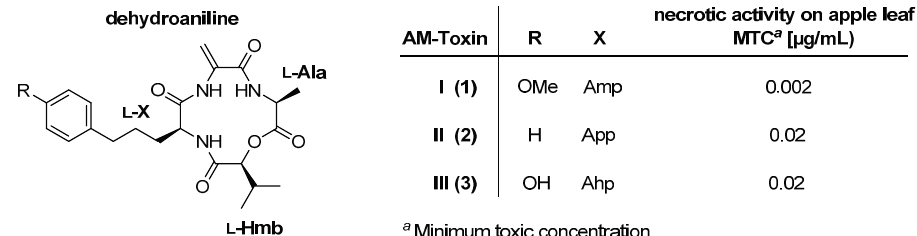
Figure 2. Structures of AM-toxins I-III ( 1 – 3